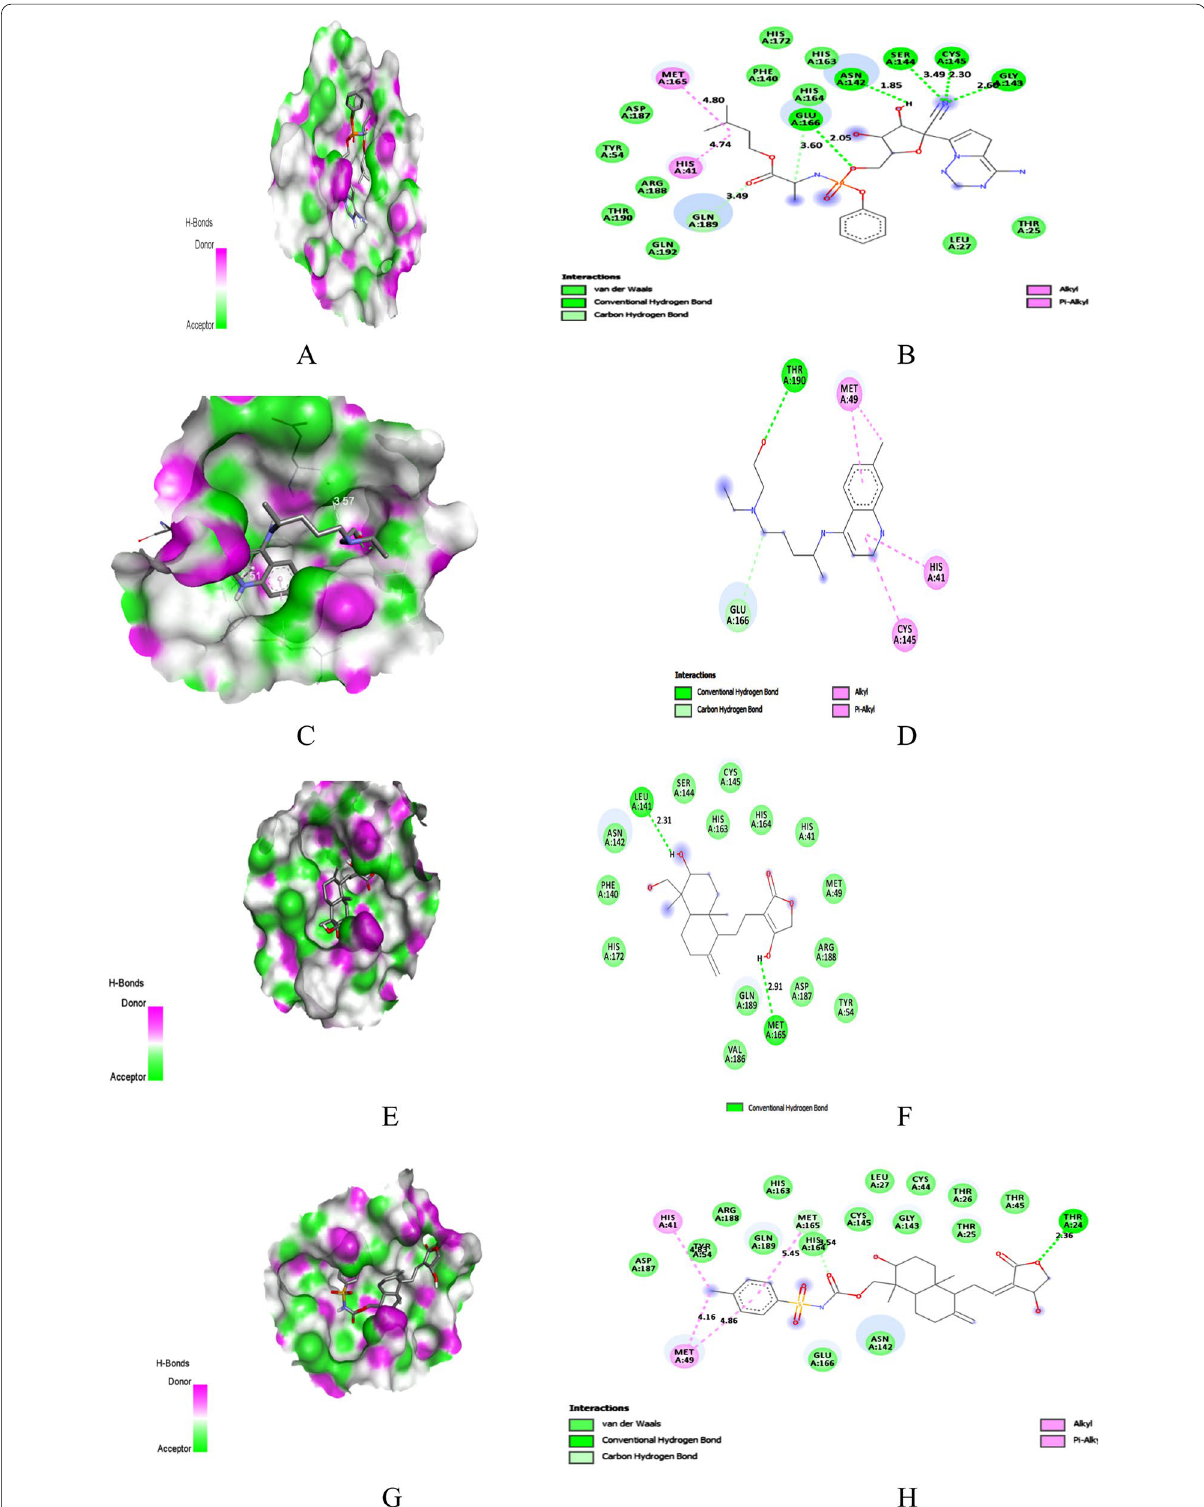
Fig. 3 Docking with Mpro. A Docking pose of REM on hydrogen bonding surface. B 2D interaction of REM. C Docking pose of HCQ on hydrogen bonding surface. D 2D interaction of HCQ. E Docking pose of AGP on hydrogen bonding surface. F 2D interaction of AGP. G Docking pose of AGP-16 on hydrogen bonding surface. H 2D interaction of